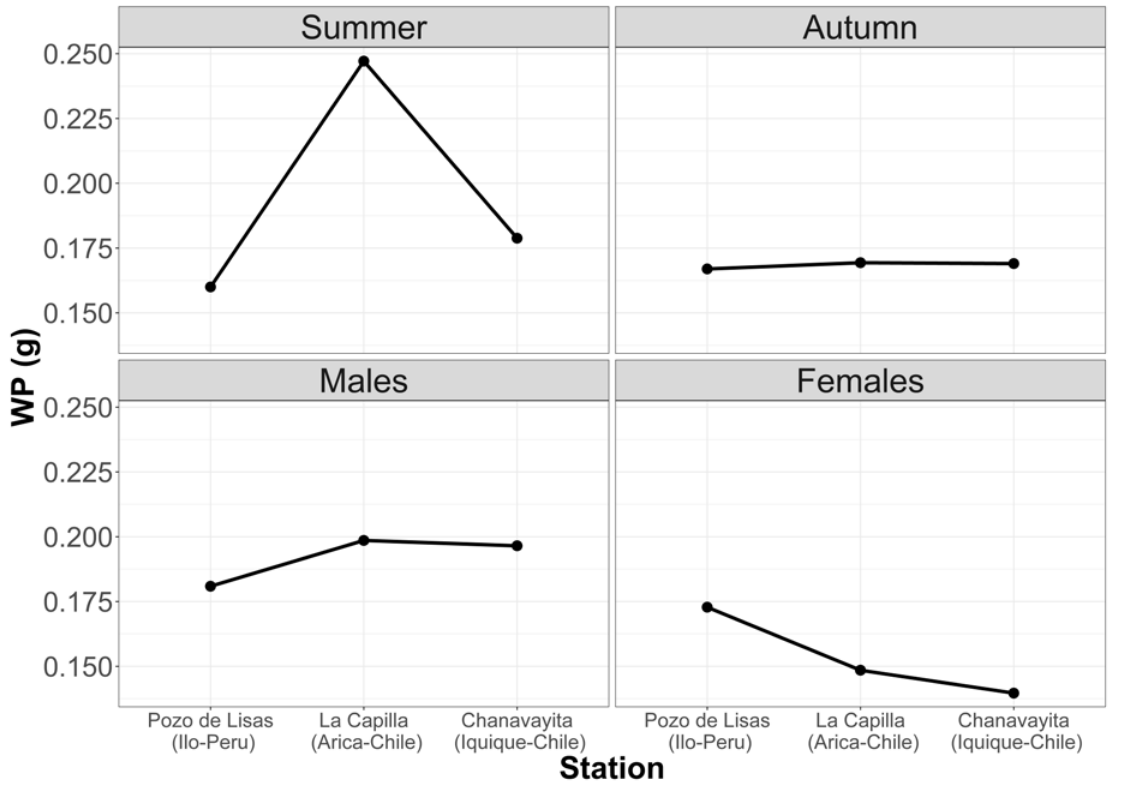
Figure 5. Average weight of prey with respect to seasons and sex in the three study